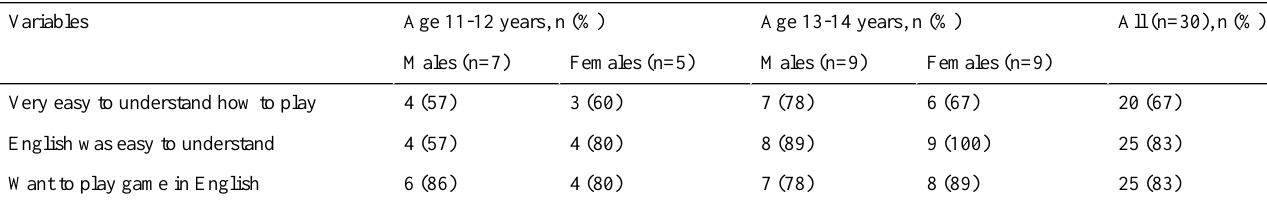
Table 5. Frequency and percentage of respondents responding most positively to questions on usability and understandability by